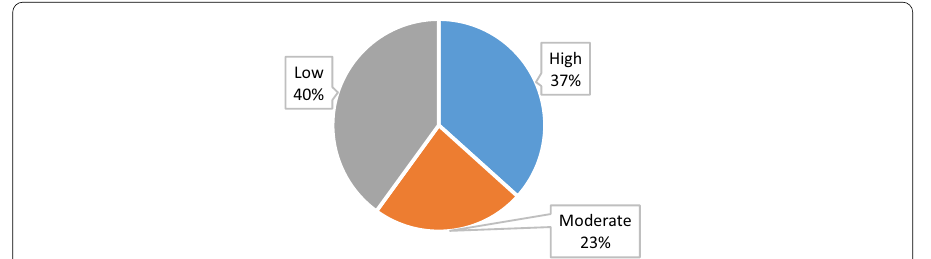
Fig. 14 Distribution of participants with respect to correlation values between selfies and average